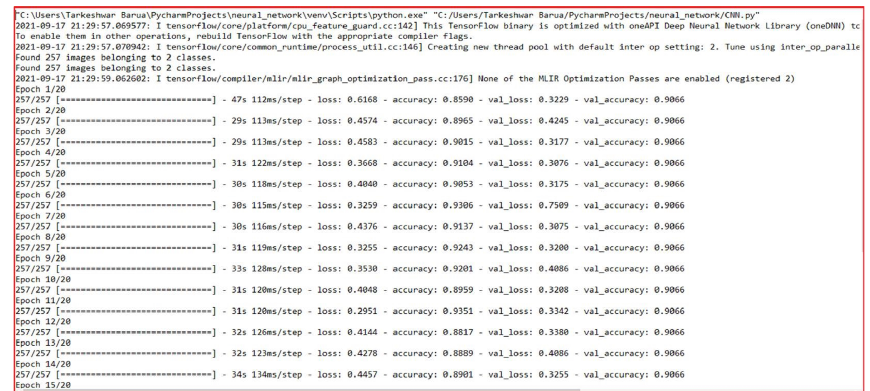
Figure 9: Final output of the Omicron CT-scan image data set from the Kaggle dataset. Table 1: Comparison metrics with ECNN and ERNN techniques. Sl.